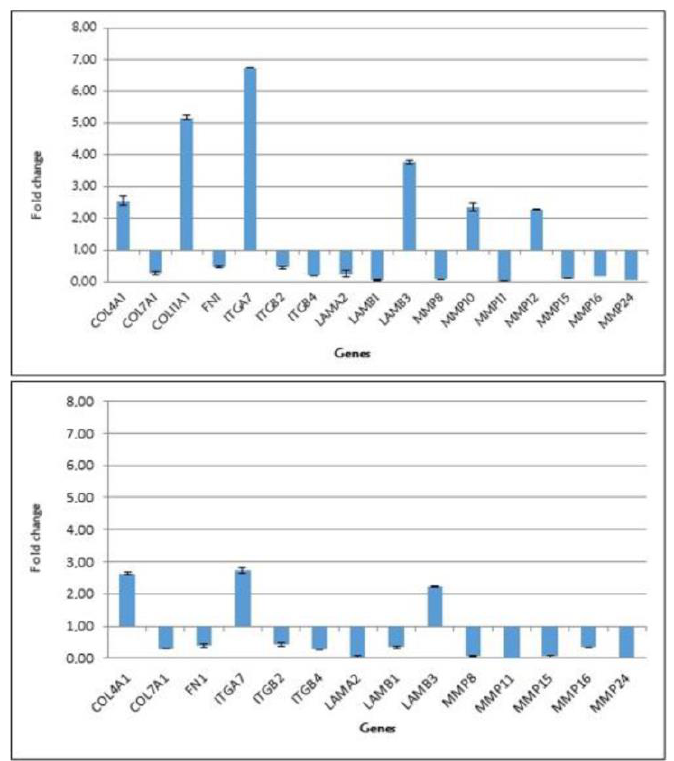
Figure 1. Significant expression levels of the genes up- and downregulated in fibroblast cells treated with diphenylhydantoin (chart above) and gabapentin (chart below).